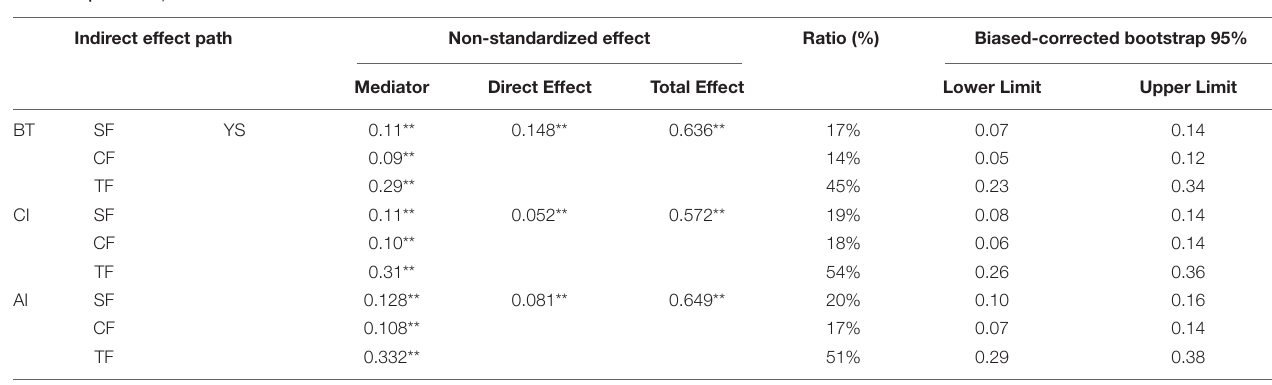
TABLE 5 | Bootstrap